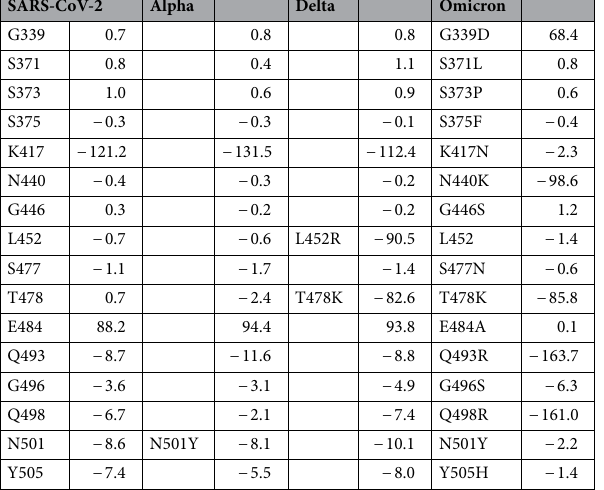
Table 2. Decomposition energies per residue in kcal/mol for the main mutation positions of RBD WT, Alpha, Delta and